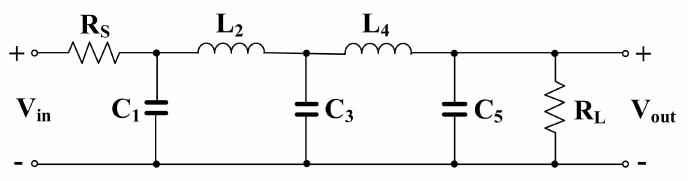
Figure 2. Prototype of a fifth-order low-pass